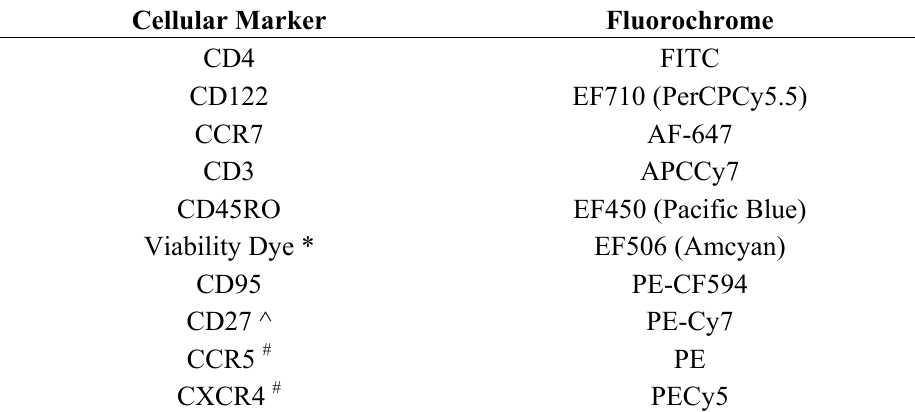
Table 1. Flow cytometry panel for the detection of CD4 + T cell